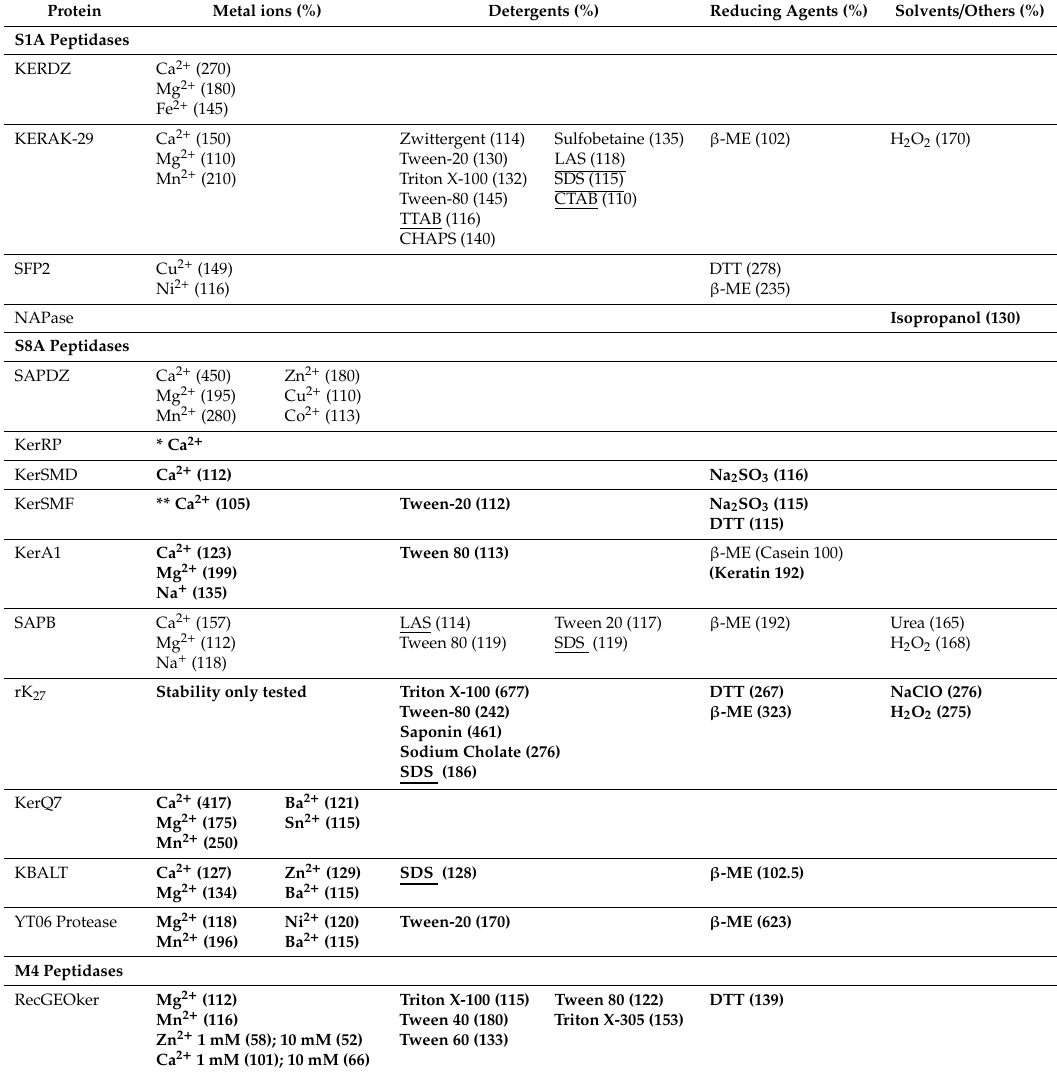
Table 5. Influence of additives on the activity of selected S1, S8 and M4 keratinases. Numbers in brackets correspond to the % activity compared to 100% in the absence of the